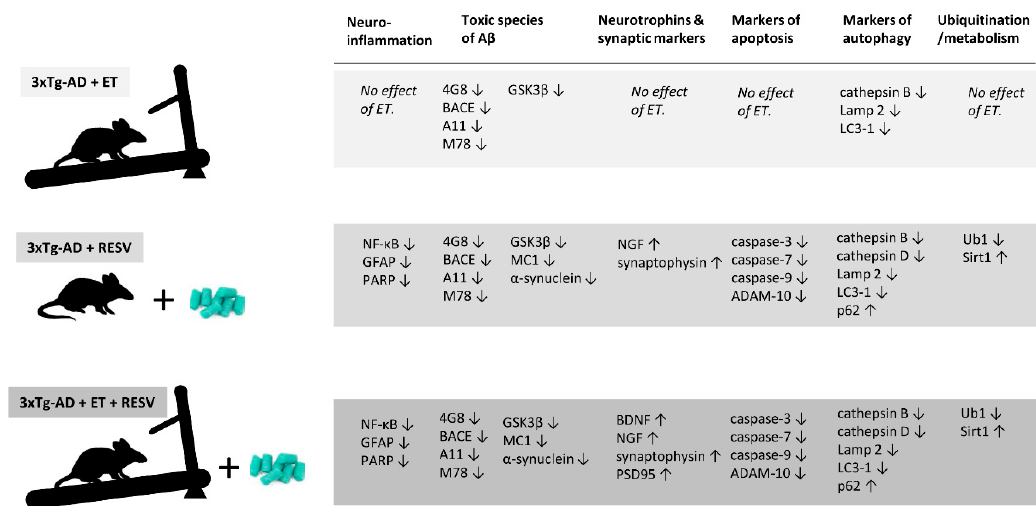
Figure 9. Summary of the effects of Resv and ET on proteins of interest. Changes are expressed as increased ( ↑ ) or decreased ( ↓ ) based on the Western blot data compared to brain tissue obtained from 3xTg-AD mice serving as controls (Figure 1). The greatest protection was afforded by treatment with Resv alone or by Resv combined with ET.